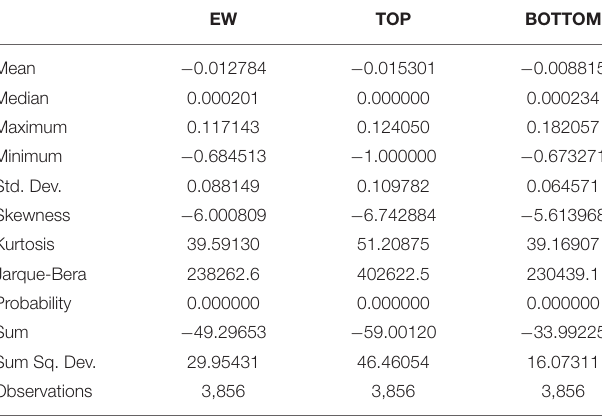
TABLE 3 | Descriptive statistics of the three insurance-based stock